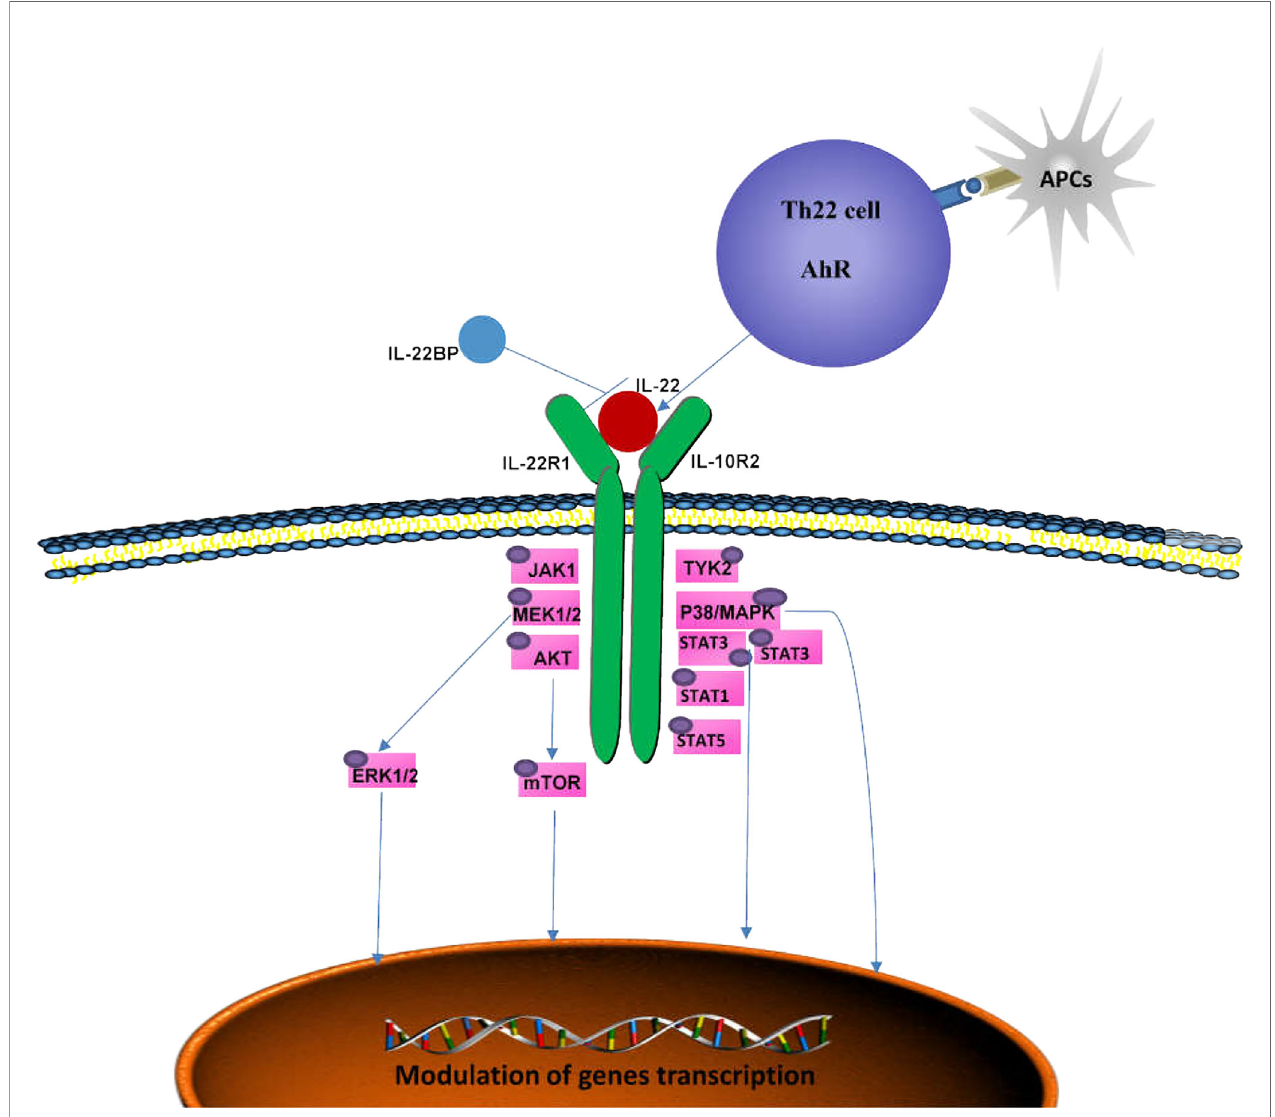
FIGURE 1 | Signaling pathways mediated by IL-22. The IL-22 receptor complex consists of IL-22R1 and IL-10R2. By binding to its receptor, IL-22 activates TYK2 and JAK1and triggers multiple intracellular pathways, including p38MAPK, MEK1/2, ERK1/2 and AKT, by phosphorylating serine and tyrosine in STAT3, STAT1 and STAT5, which can ultimately lead to immune homeostasis. IL-22BP is a soluble receptor antagonist that speci fi cally neutralizes the activity of IL-22. AhR, aryl hydrocarbon receptor; APCs, antigen-presenting cells; JAK1, Jenus kinase 1; TYK2, tyrosine kinase 2; MAPK, mitogen-activated protein kinase; IL-22BP, IL-22 binding